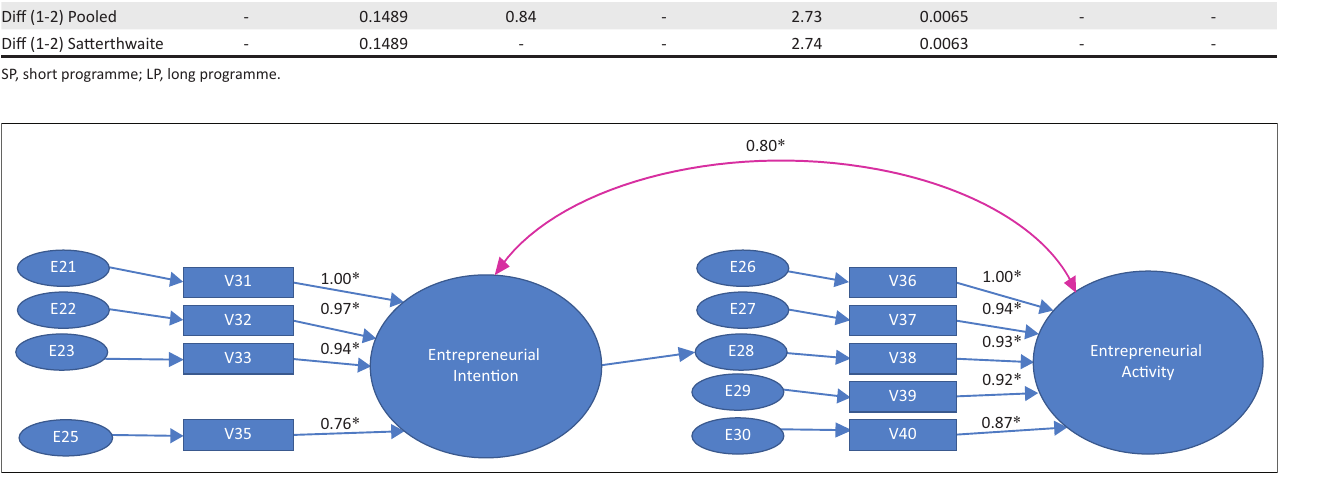
FIGURE 7: Confirmatory factor analysis on entrepreneurial activity. TABLE 11: Entrepreneurial activity factor loadings. Variable Factor description